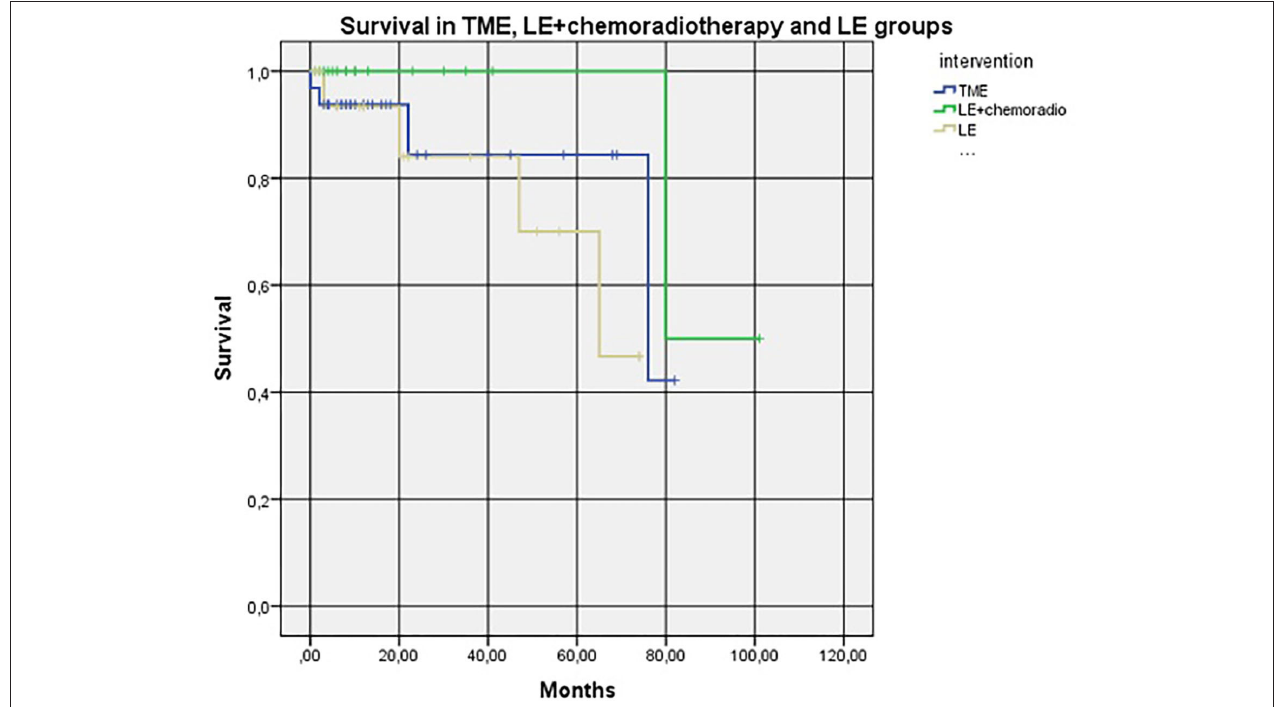
FIGURE 3 | Kaplan–Meier Cox diagrams evaluating survival in three groups (subgroup analysis). Log Rank (Mantel-Cox) p -value = 0.236. LE + chemoradio-local excision + chemoradiotheraphy. LE, local excision. TME, total mesorectal excision.